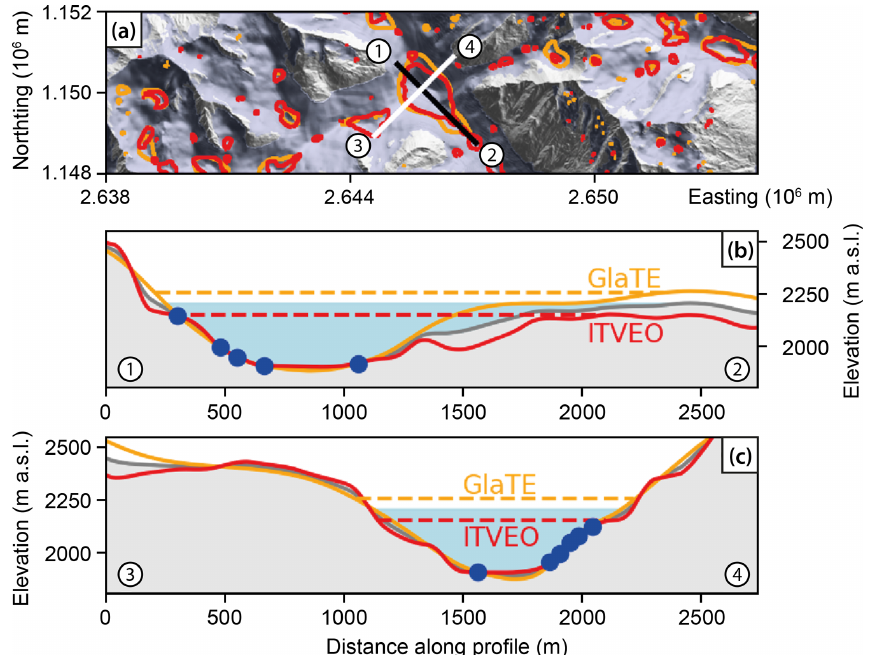
Figure 7. (a) Comparison between the potential lakes detected by GlaTE (orange) and ITVEO (red) for Gr. Aletschgletscher (see Fig. 1 for location). The glacier area of the SGI2016 is marked in blue. The black and white lines provide the locations of the profiles displayed in panels (b) and (c) , respectively. (b–c) Illustration of the bedrock topography (orange: GlaTE; red: ITVEO; grey: mean) for the profiles given in panel (a) . GPR measurements are indicated (blue dots) together with the lake levels resulting from the three topographies (blue is the lake for the mean